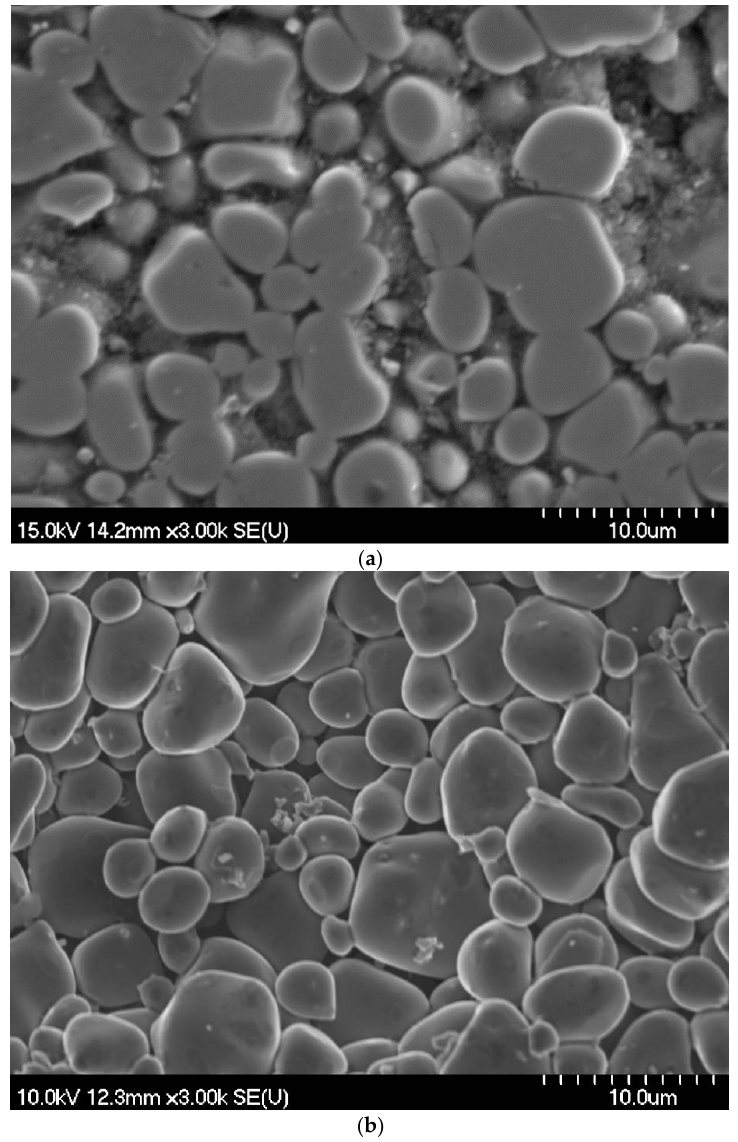
Figure 7. Representative SEM images of the post-corrosion surfaces of the TiC–stainless steel cermets following potentiodynamic polarisation testing, for cermets with binder contents of: ( a ) 30 vol. % 316 L and ( b ) 30 vol. % 410 L.